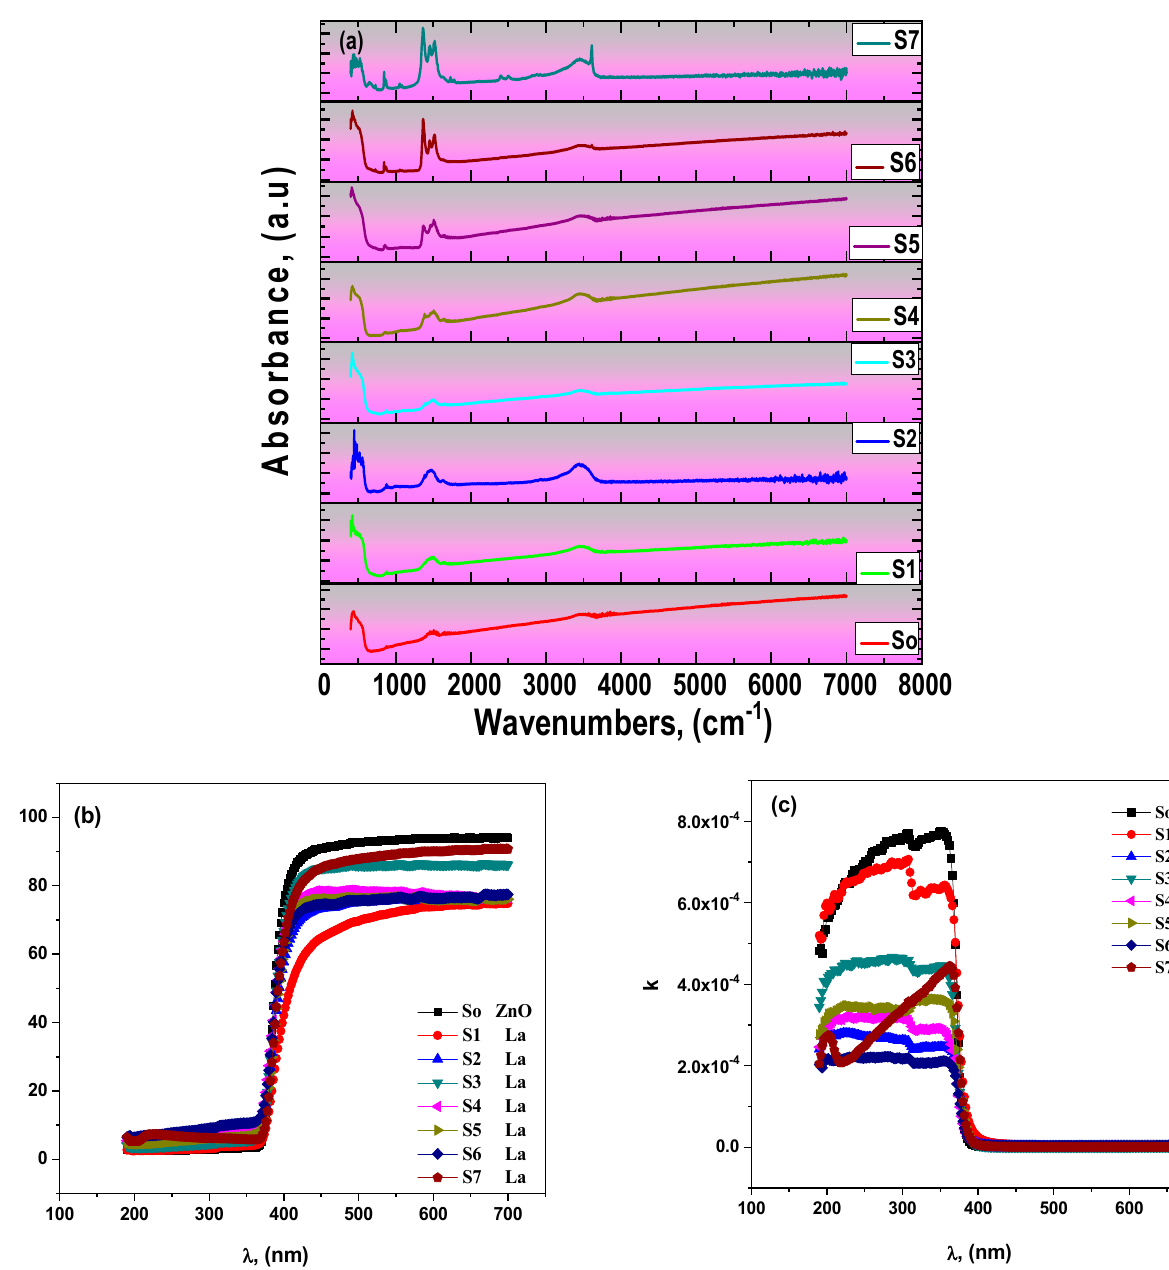
Figure 3. ( a – c ): ( a ) FT-IR spectra, ( b ) diffused reflectance (ODR), and ( c ) absorption index (k) of the as-prepared La 2 O 3 -ZnO nanostructured composites at different lanthanum oxide concentrations (S1–S7).